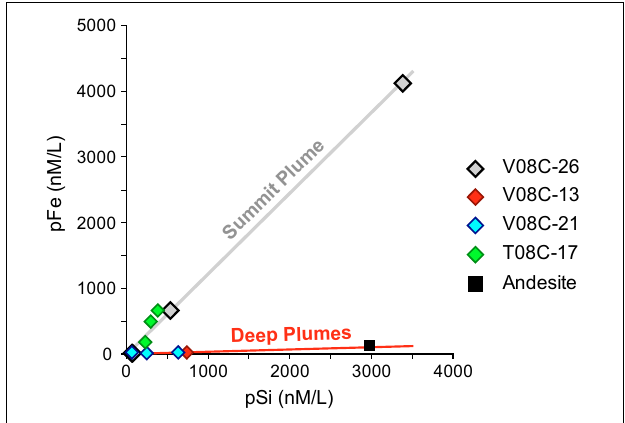
FIGURE 5 | Fe/Si ratio of particulates from deep ash plumes compared to magmatic-hydrothermal plumes from over the summit of West